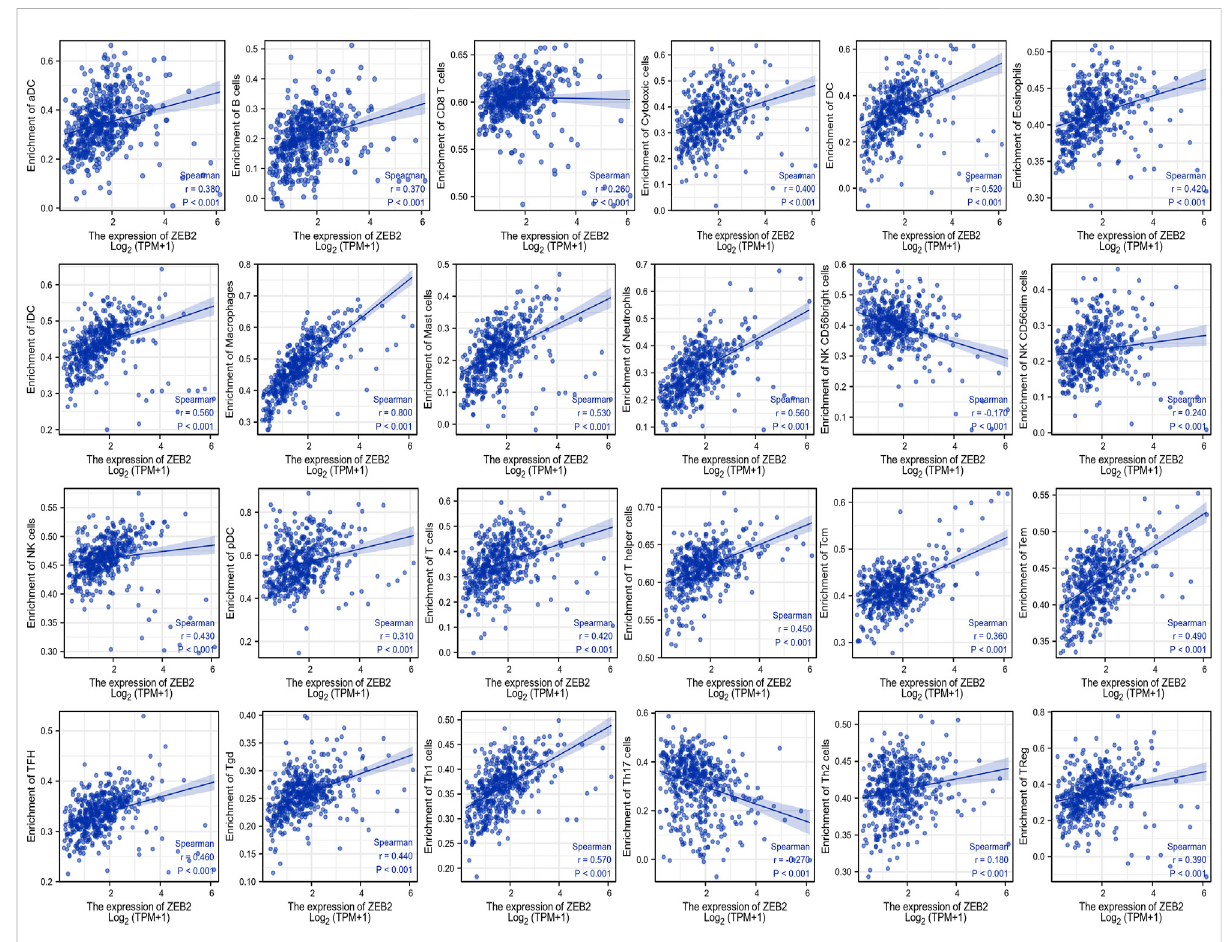
FIGURE 3 The correlation between ZEB2 expression and 24 immune cells based on TCGA